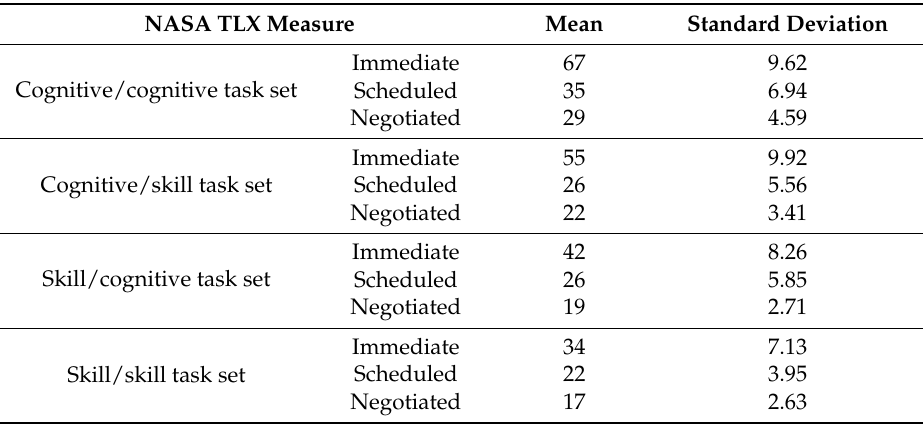
Table 4. Descriptive statistics of NASA TLX data under each task set.